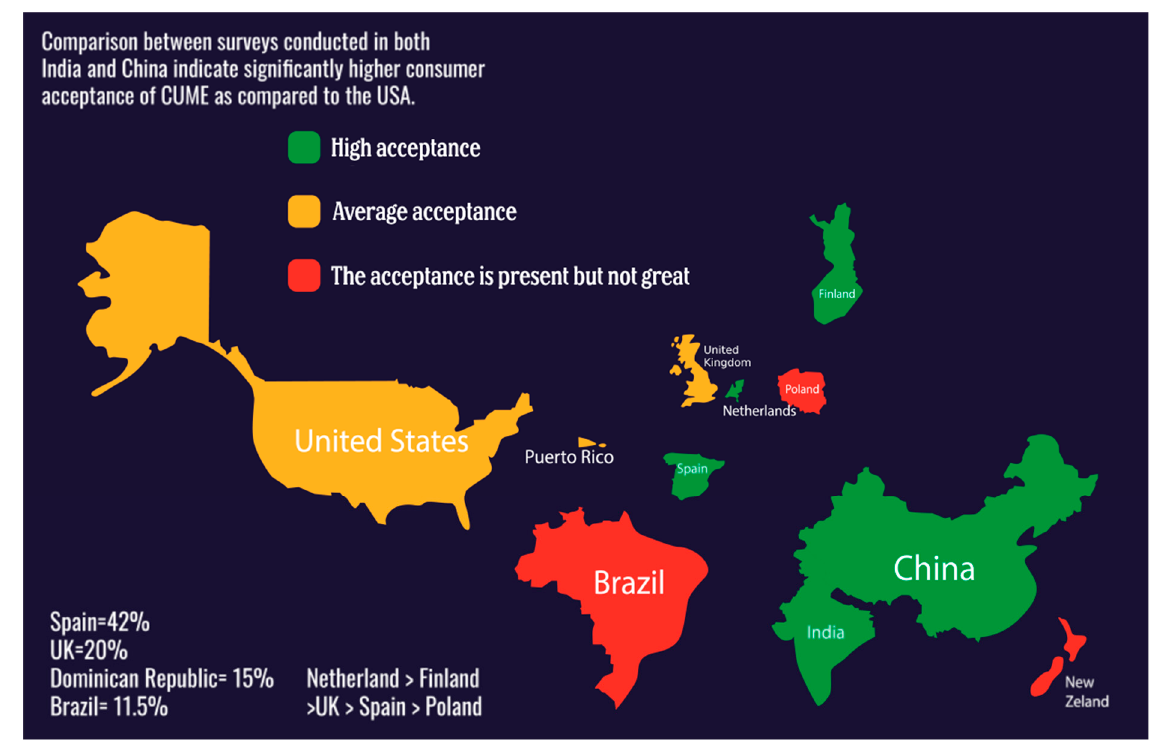
Figure 1. CUME demand characteristics by countries [13].